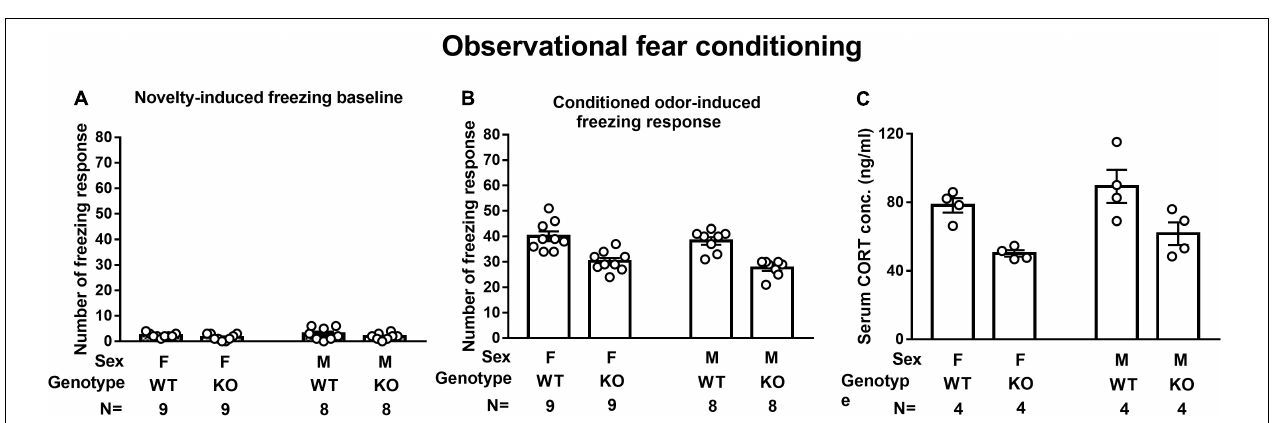
FIGURE 4 | Novelty- and observational conditioning-induced freezing response (FR) and observational fear conditioning-induced corticosterone (CORT) secretion. (A) Regardless of sex and genotype, mice had indistinctive novelty-induced freezing baselines. (B) SEPT14 KO mice had dampened conditioned vanilla odor-induced FR as compared to WT mice [ F (1,30) = 45.48, p < 0.0001]. (C) SEPT14 KO mice had dampened observational conditioning-stimulated CORT secretion as compared with the WT ones [ F (1,12) = 19.54, p = 0.0008]. The bar and error bar represent group mean and SEM,